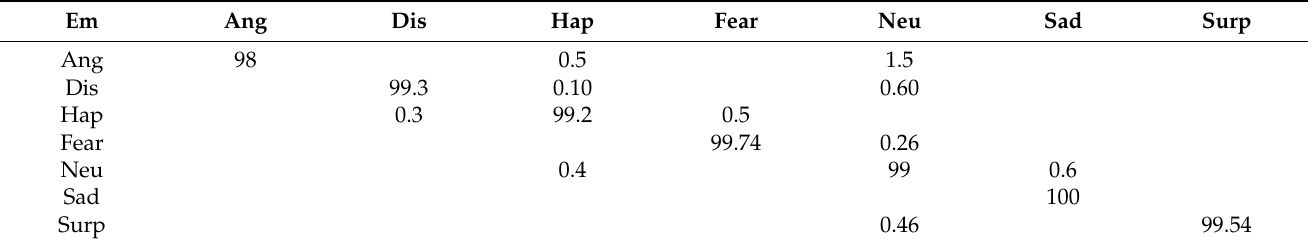
Table 3. Matrix representing the confusions in CK+ dataset.